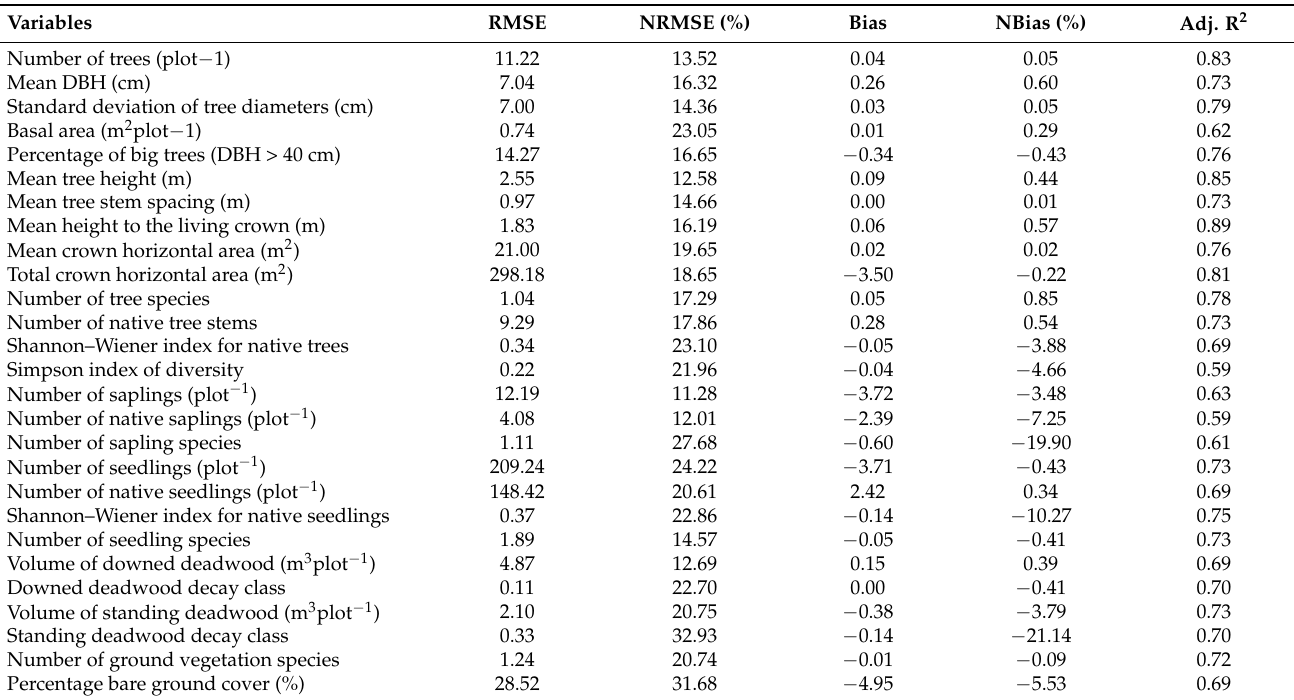
Table 3. Summary statistics of each random forest model using metrics from the leaf-off acquisition, with absolute and normalised root mean square error (RMSE and NRMSE); absolute bias and normalised bias (NBias); and the adjusted coefficient of determination (Adj. R 2